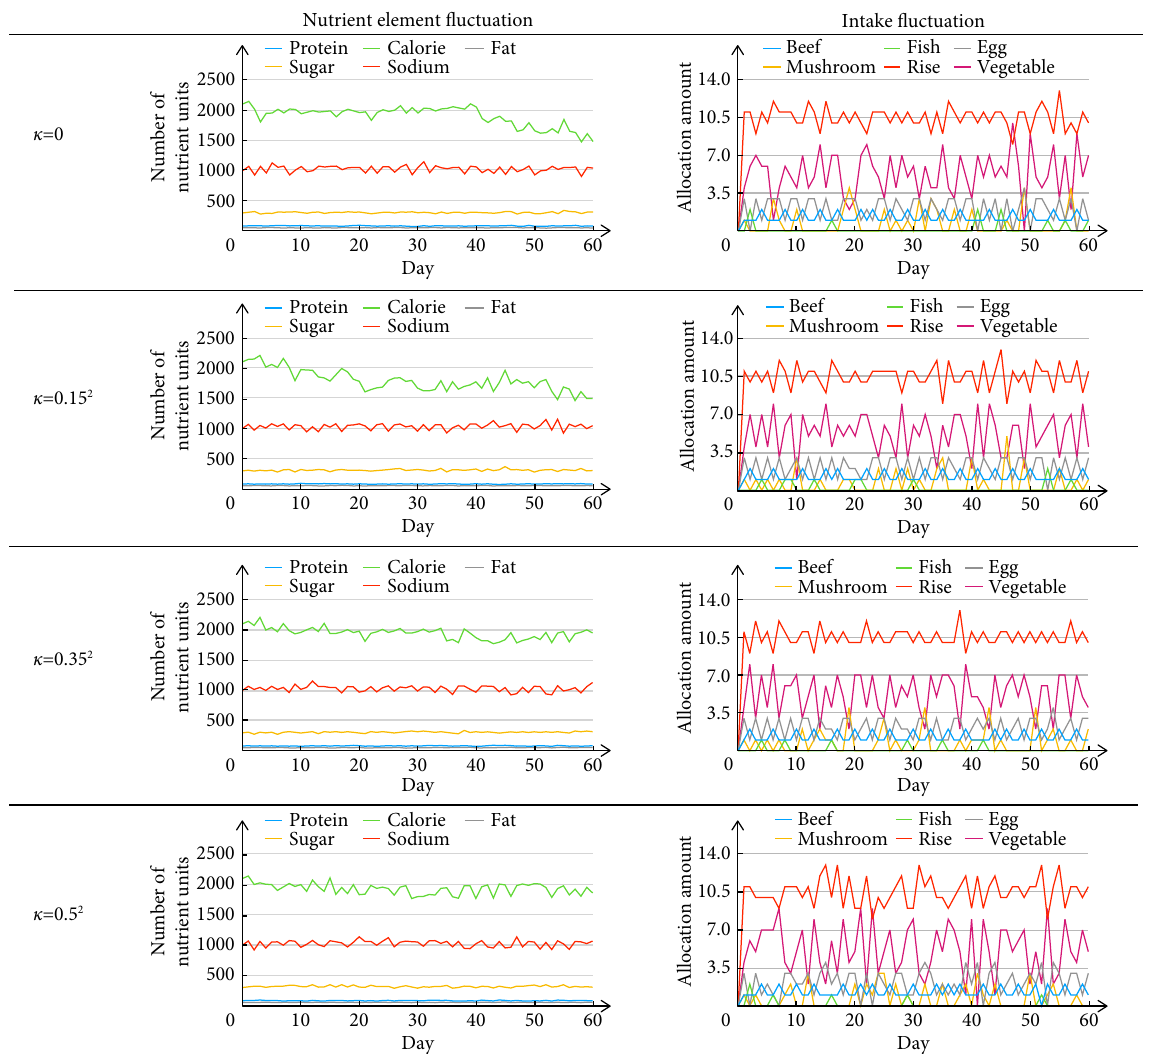
κ Fig. 2 Evolution process under different fluctuation coefficients . A great fluctuation coefficient does not have a noticeable effect on the